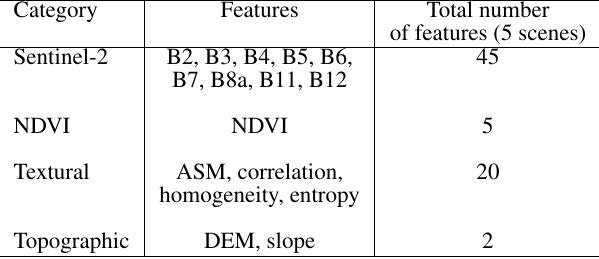
Table 2. Summary of input features.